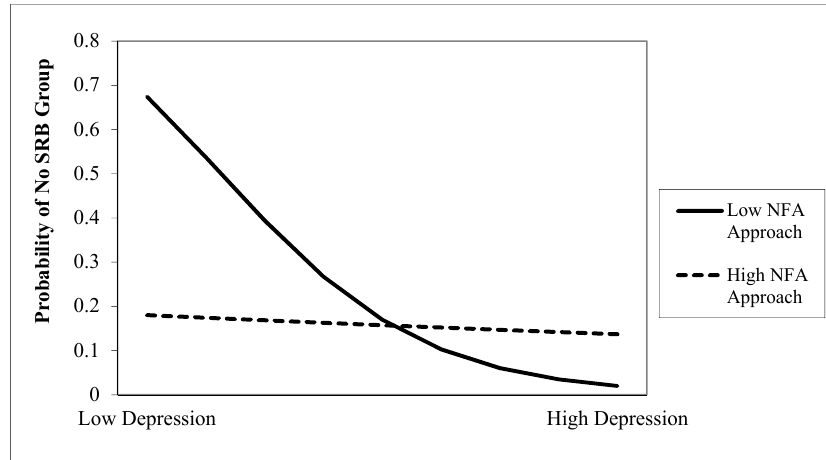
Figure 1. Two-way interaction of depression x Need for Affect Approach predicting no suicide-related behavior group status (ideation reference group). Notes: SRB = Suicide-related behavior; NFA = Need for Affect; Low/High = ±1 standard deviation around the mean.